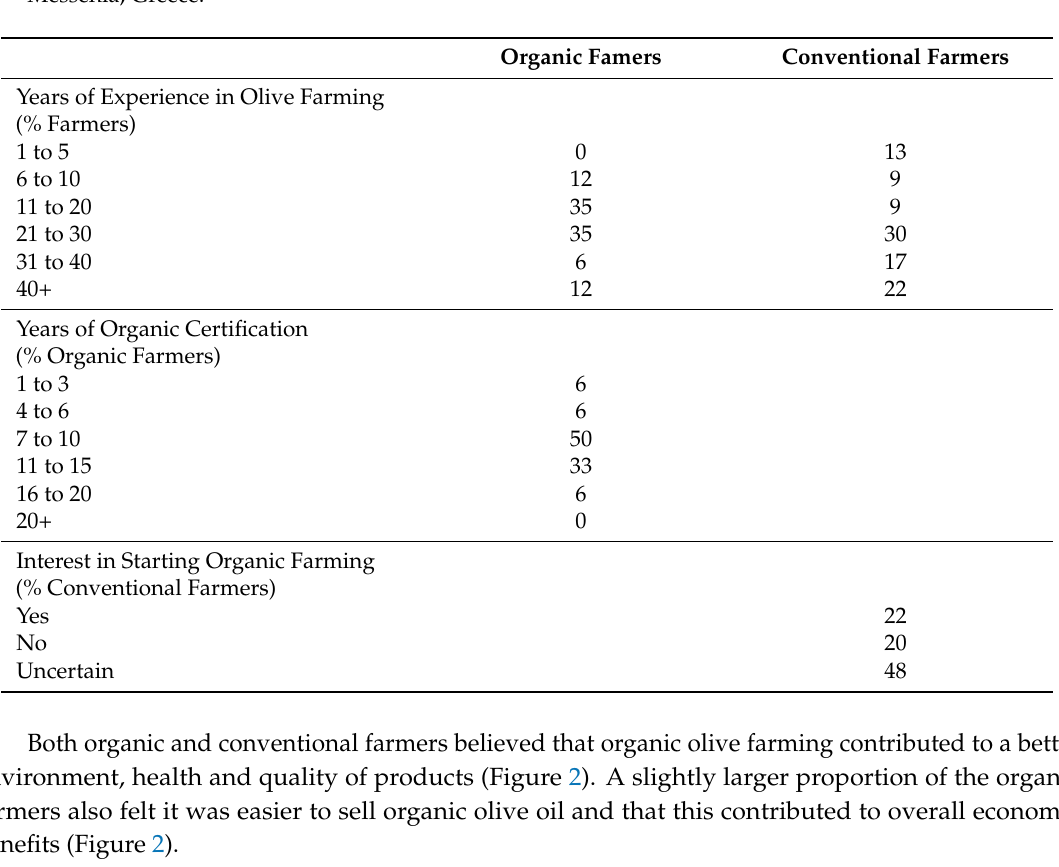
Table 2. Experience of olive farming among organic ( n = 16) and conventional ( n = 23) olive farmers in Messenia, Greece.